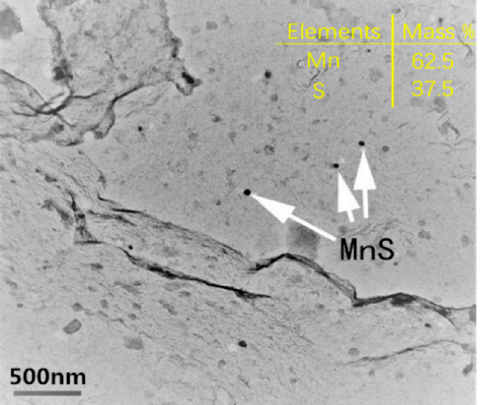
Figure 10. TEM image of nanosized MnS with 20 ppm sulfur content.